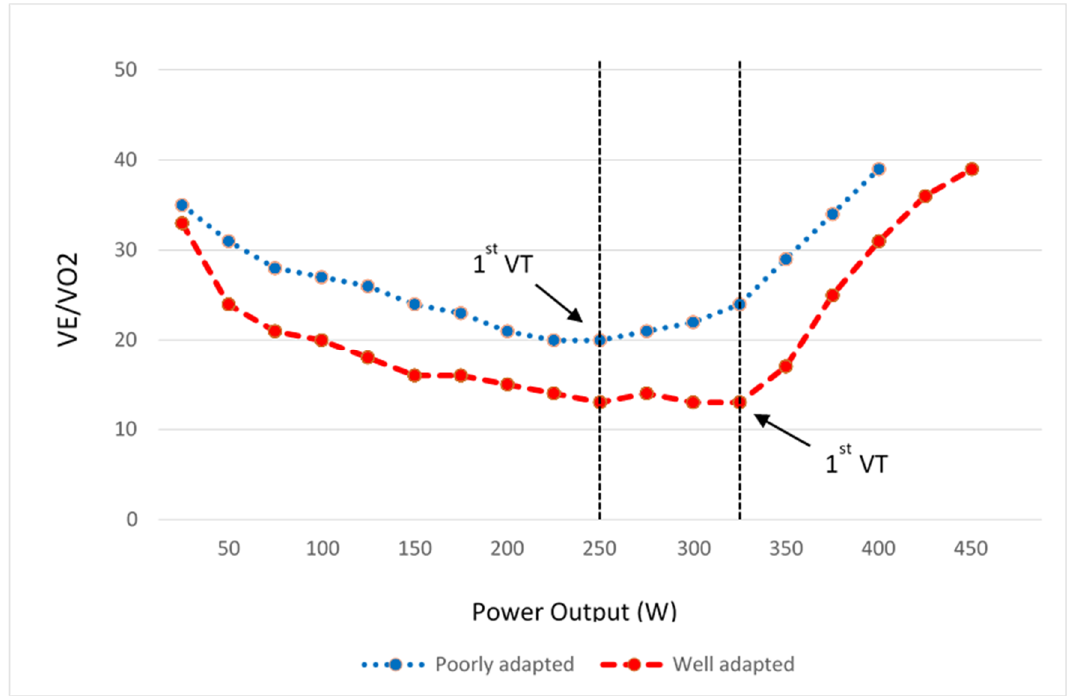
Figure 3. The ventilatory equivalent for O 2 in a well-trained athlete compared with a poorly adapted athlete. As it’s evident, the ventilatory threshold is at higher workload with lower VE/VO 2 values in well-trained athlete than their less fit peer.